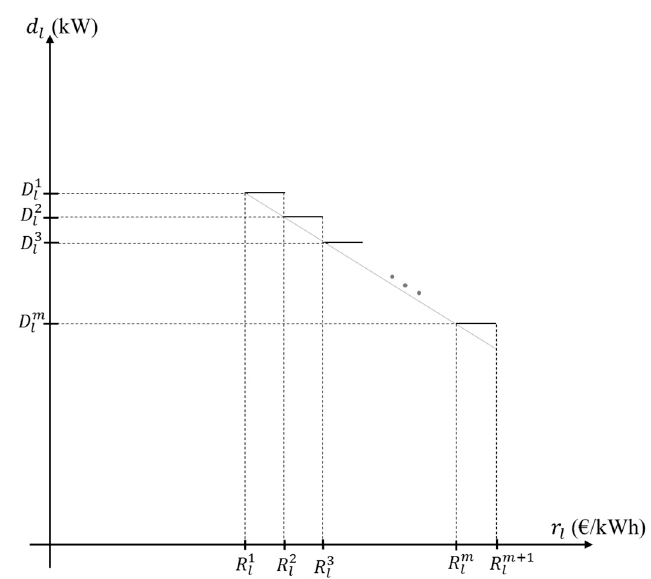
Figure 3. Blocks of the demand function.